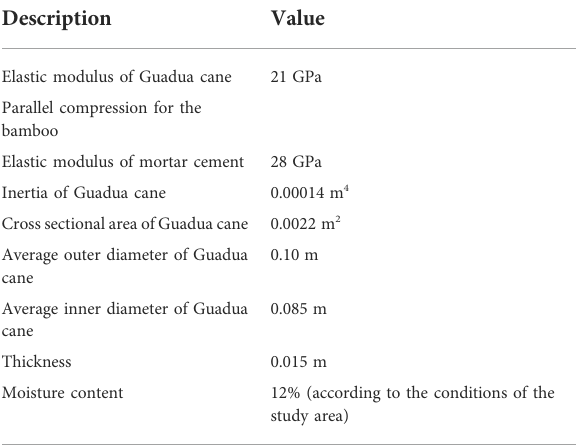
TABLE 1 Mechanical properties of materials (Ministry of Urban Development and Housing,